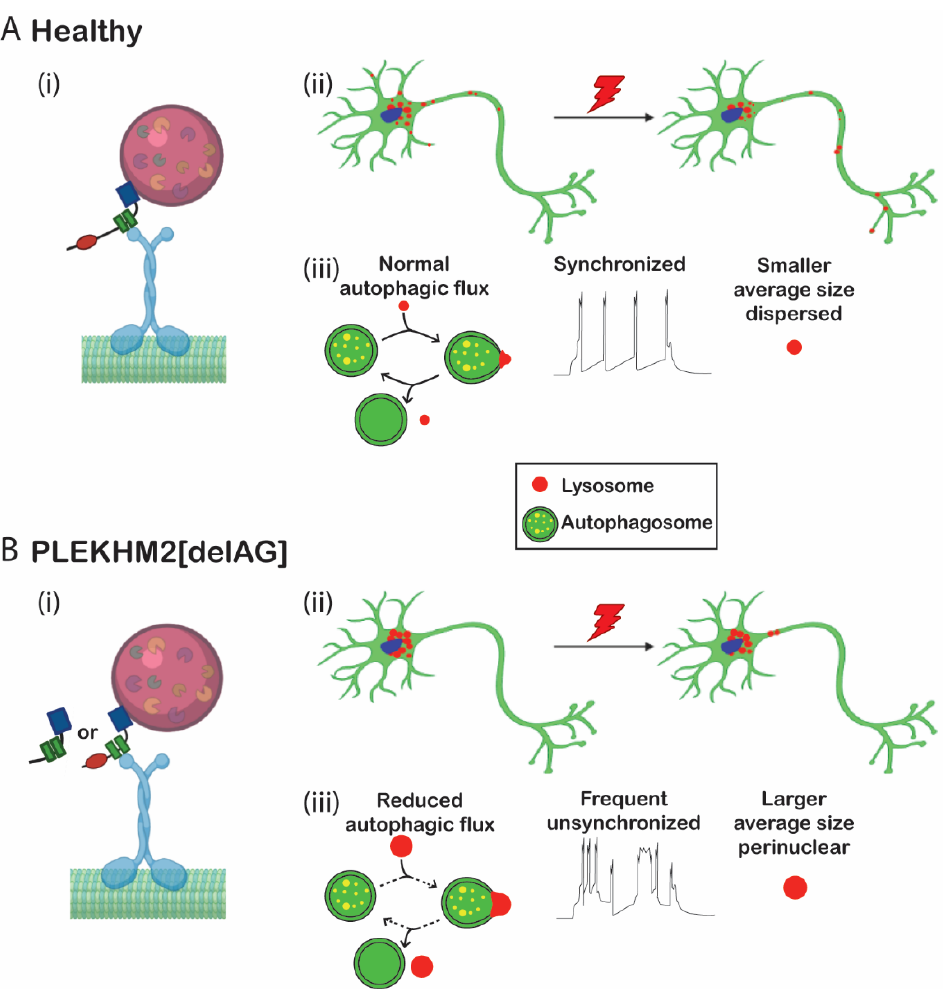
Figure 6. Suggested mechanism: large perinuclear lysosomes lead to abnormal electrophysiological activity in ( A ) healthy and ( B ) PLEKHM2[delAG] cells. ( i ) Lysosome binds to KINESIN-1 motor